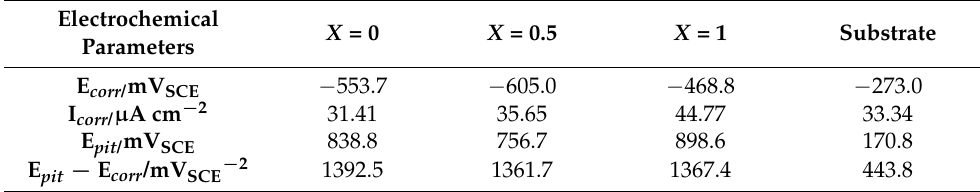
Figure 5. ( a ) Potentiodynamic polarization curves of Al x Ti 1 − x ( x = 0, 0.5, 1) in 0.5 mol/L H 2 SO 4 solu- tion, ( b ) Electrochemical impedance spectroscopy Al x Ti 1− x ( x = 0, 0.5, 1) in 0.5 mol/L H2SO4 solution. Table 4. Electrochemical parameters of Al x Ti 1 − x ( x = 0, 0.5, 1) and 904L stainless steel in 0.5 mol/L H 2 SO 4 solution.